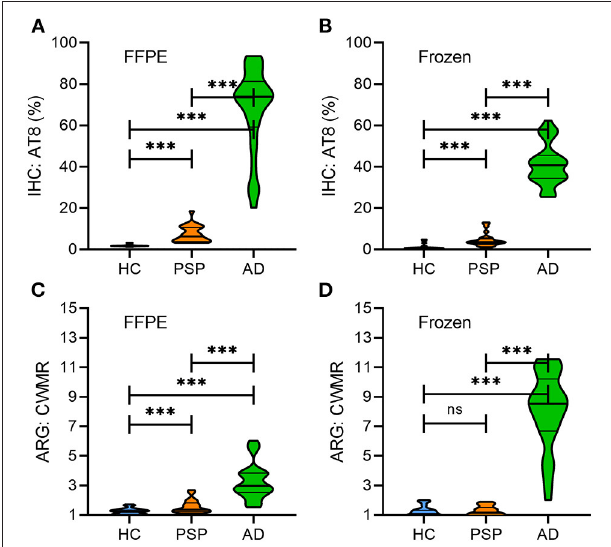
FIGURE 3 | Quantitative comparison of immunohistochemistry (% tau load) and autoradiography (cortex to white matter ratio) between HC, PSP and AD in FFPE (A,C) and frozen (B,D) tissue samples. Violin plots represent the distribution of data with the median and quartiles. HC, healthy controls, PSP, progressive supranuclear palsy; AD, Alzheimer’s disease; FFPE, formalin-fixed paraffin-embedded; IHC, immunohistochemistry; ARG,